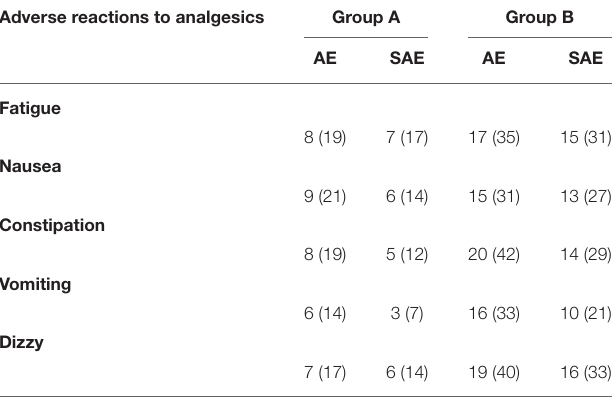
TABLE 3 | Adverse reactions to analgesics from different therapy strategies. Adverse reactions to